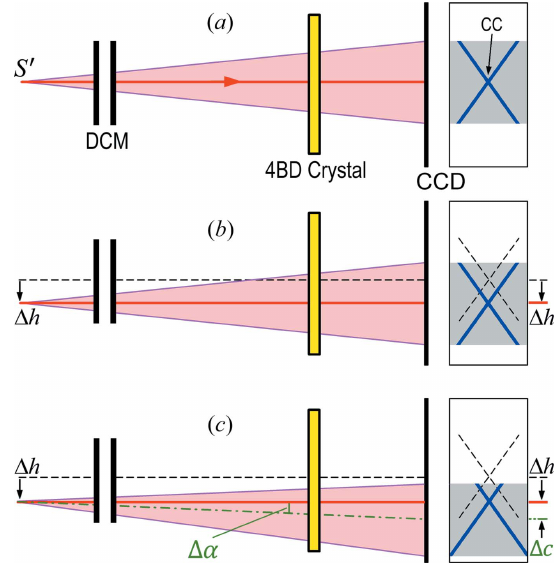
Figure 5 Schematic of the BPM using 4BD of a point source. The left-hand side shows side views. The right-hand side shows the CCD viewed along the beam direction ( K 1 in Fig. 1). The beam displacement caused by the DCM is not shown, which does not affect the BPM. Since the deflection angle (2 (cid:2) 4B ) of the 4BD crystal is omitted, the source S 0 is the virtual source in Fig. 4( a ). For simplicity the 2D variations of the source, the beam and the image are indicated by 1D shifts. ( a ) Initial 4BD configuration. ( b ) S 0 is displaced by (cid:4) h without beam direction changes. ( c ) S 0 is displaced by (cid:4) h together with a beam direction change (cid:4) (cid:6) , which makes the 4BD pattern asymmetric as the image center is shifted by (cid:4) c = D (cid:4) (cid:6) from the